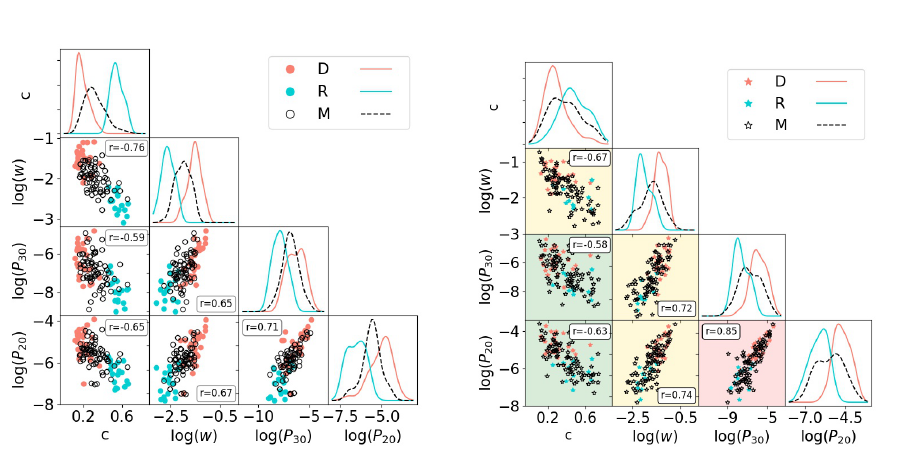
Figure 1. Correlations between the morphological parameters estimated from the observations (left) and simulations (right). Relaxed (R), disturbed (D), and mixed (M) clusters are shown in orange, cyan, and black, respectively. The background colours of the right plot represent the level of confidence between the observed and simulated Spearman coe ffi cient, r (green stays for a level of confidence below 1 σ , yellow is for a level of confidence between 1 - 3 σ and red is for a level of confidence above 3 σ